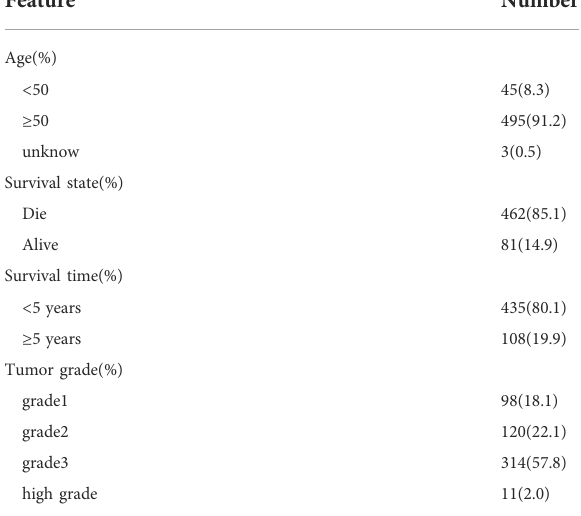
TABLE 1 Demographic characteristics of the study